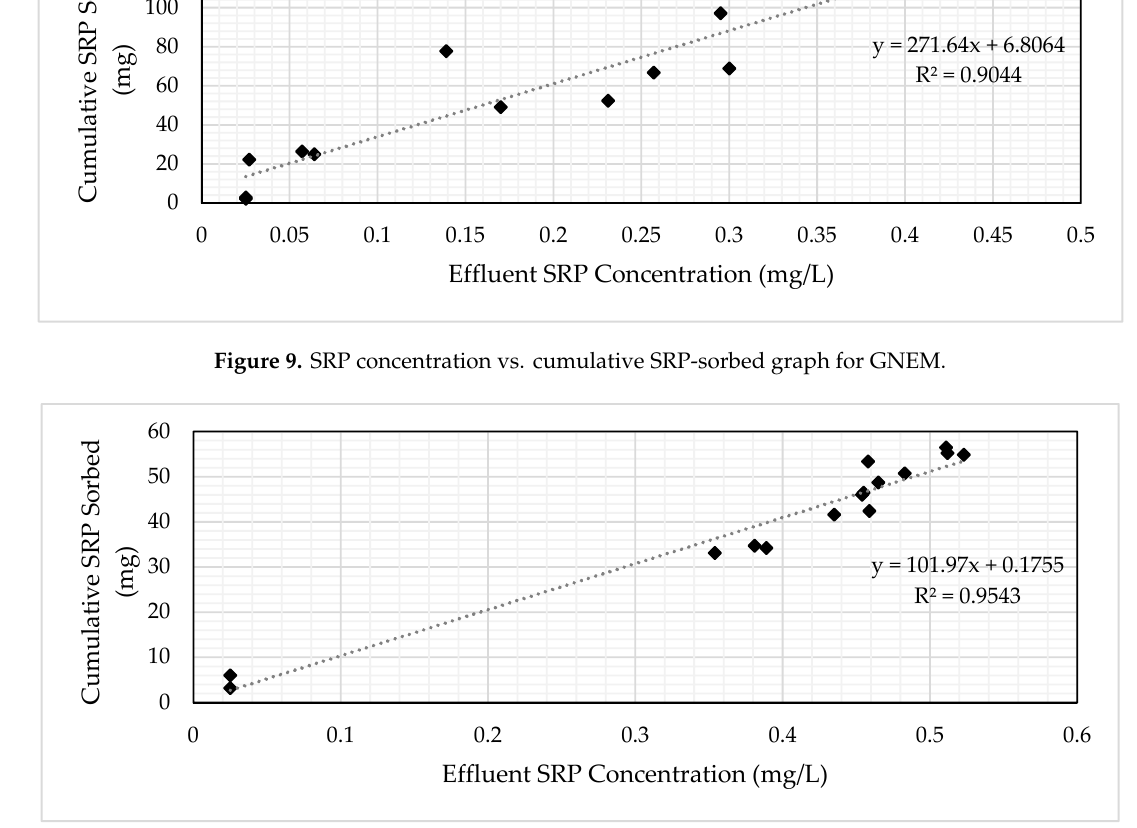
Figure 10. SRP concentration vs. cumulative SRP-sorbed graph for SFS. Table 7. Measured GNEM and SFS column characteristics. PSM: phosphorus sorbing